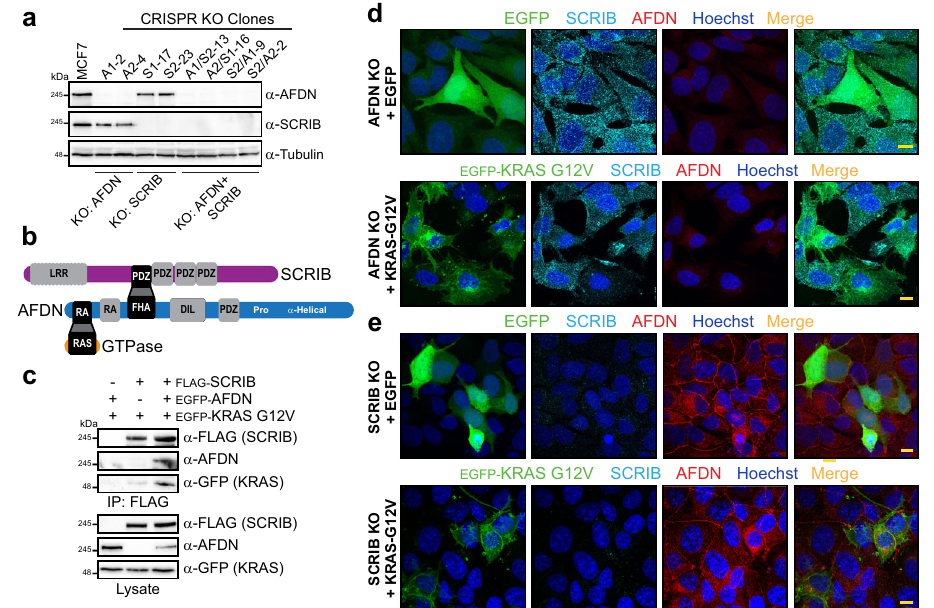
Fig.6|KOof AFDN and SCRIB inMCF7cells.a IndividualclonesofMCF7cellswere selected following CRISPR KO of AFDN , SCRIB or both AFDN / SCRIB with two dif- ferent guide sequences. Western blot with antibodies recognizing endogenous AFDNorSCRIBcon fi rmedtheproteinsarenotexpressed.Sourcedataareprovided intheSourceData fi les. b ModeloftheSCRIB-AFDN-RASGTPasecomplexbasedon ourdata. c KRASdoesnotcomplexwithSCRIBintheabsenceofAFDN.FLAG-SCRIB wasexpressedin AFDN KOMCF7cellstogetherwithEGFP-KRAS-G12V.FollowingIP with anti-FLAG, activated KRASdid not co-precipitate with SCRIB unless cellswere